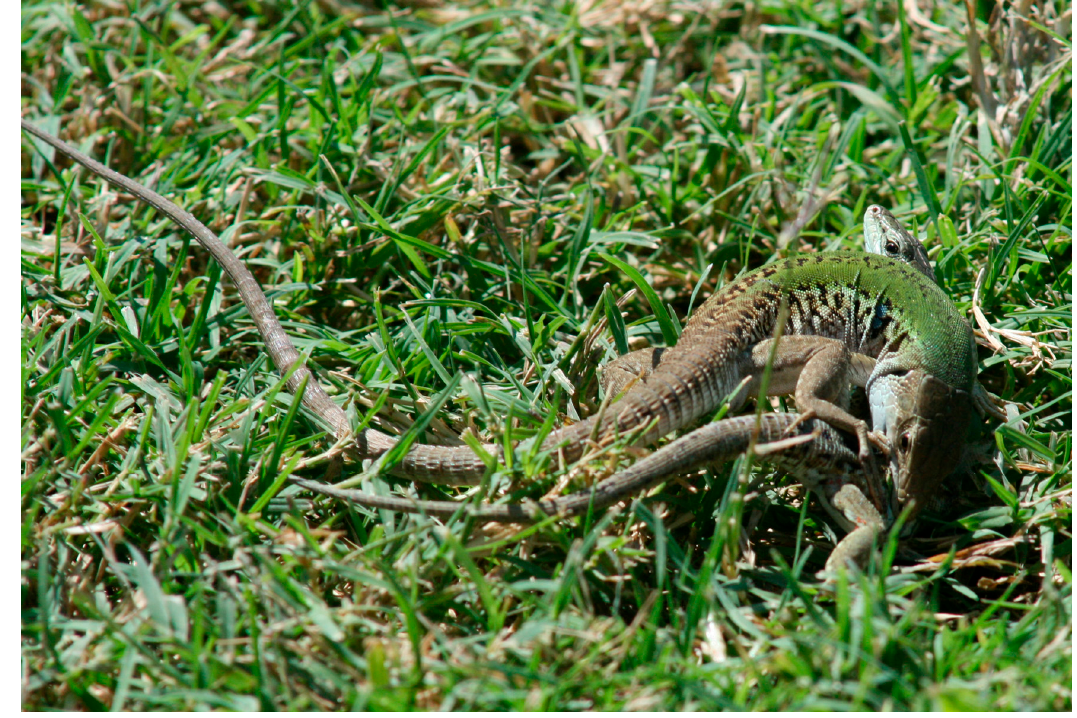
Figure 1. Adult specimens of Podarcis sicula during copulation.